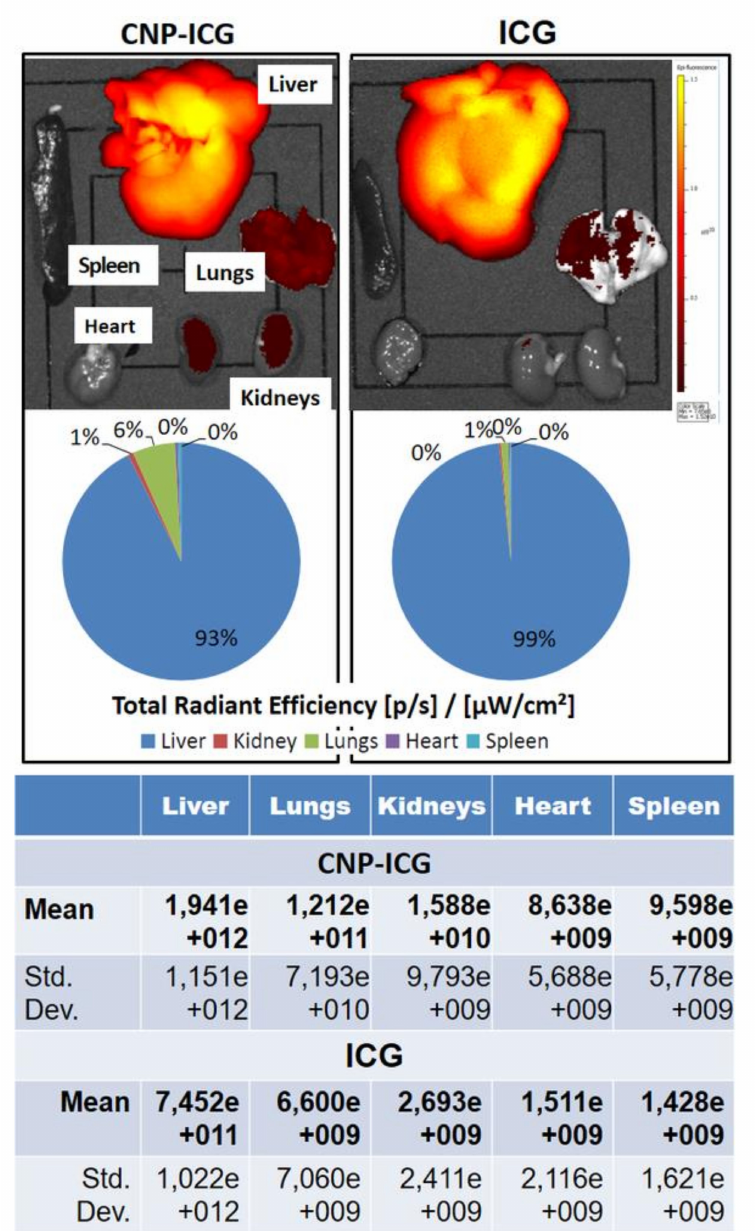
Figure 5. In loco biodistribution pattern of free and CNP-immobilized ICG 30 min after intravenous administration. The diagrams show the percentage of fluorophore accumulation in organs measured as total radiation e ffi ciency ([p / s] / [ µ W / cm 2 ]). Percentage are calculated from the mean of total radiant e ffi ciency (given in the table) for each organ ( n =